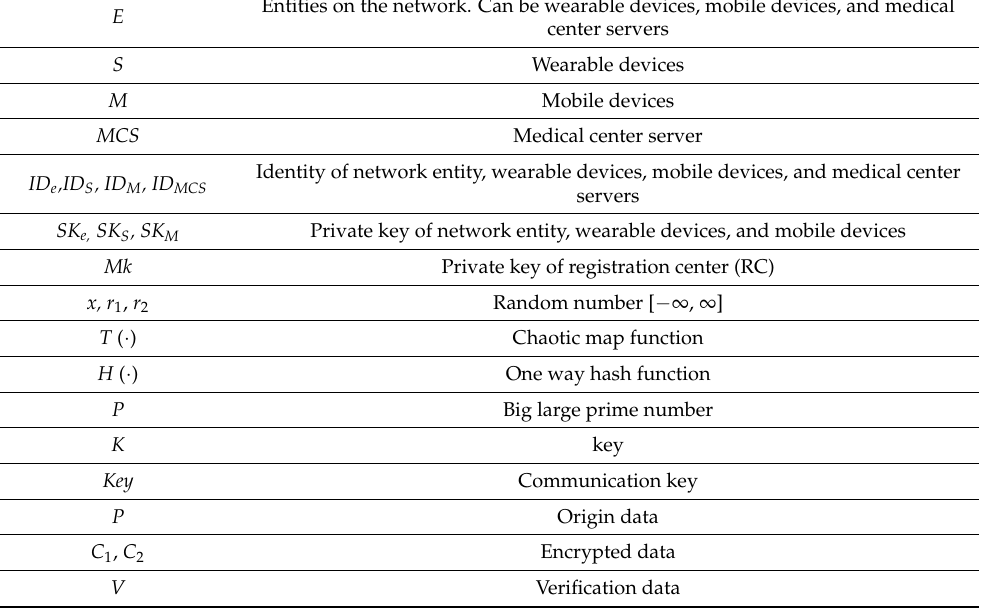
Table 2. Symbol of the